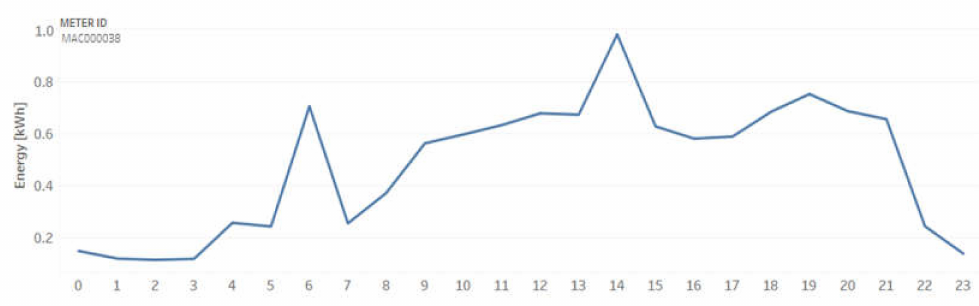
Figure 3. Example of a household energy consumption with a standard tari ff .